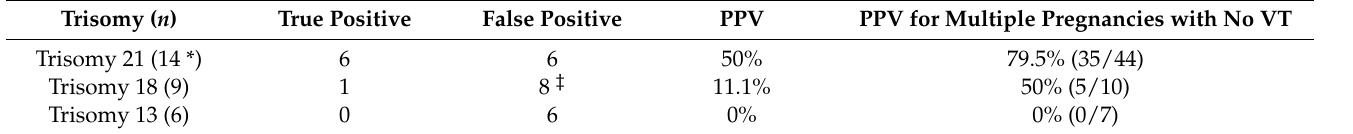
Table 4. Outcomes for high-risk NIPT